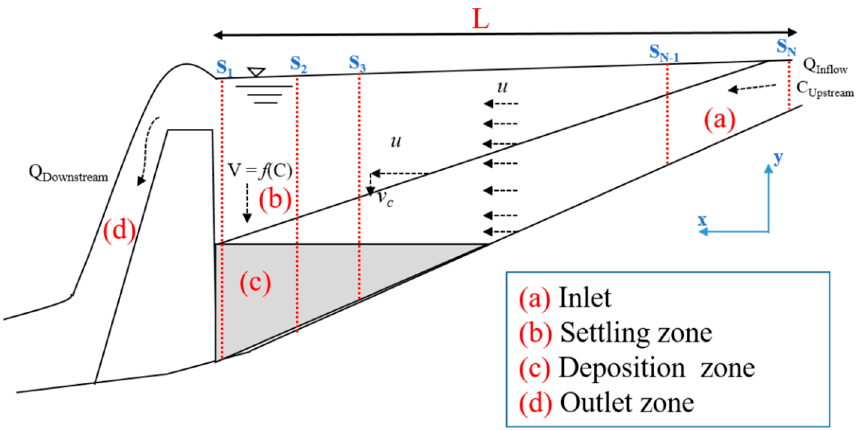
Figure 2. Sketch of the Lobo reservoir with the characteristic zones. Explanations: (a) inlet zone, (b) settling zone, (c) deposition zone, and (d) outlet zone. S1, S2…SN are a cross-section of the Lobo River reservoir.